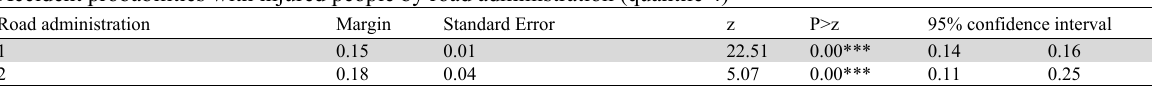
Accident probabilities with injured people by road administration (quantile 4) Road